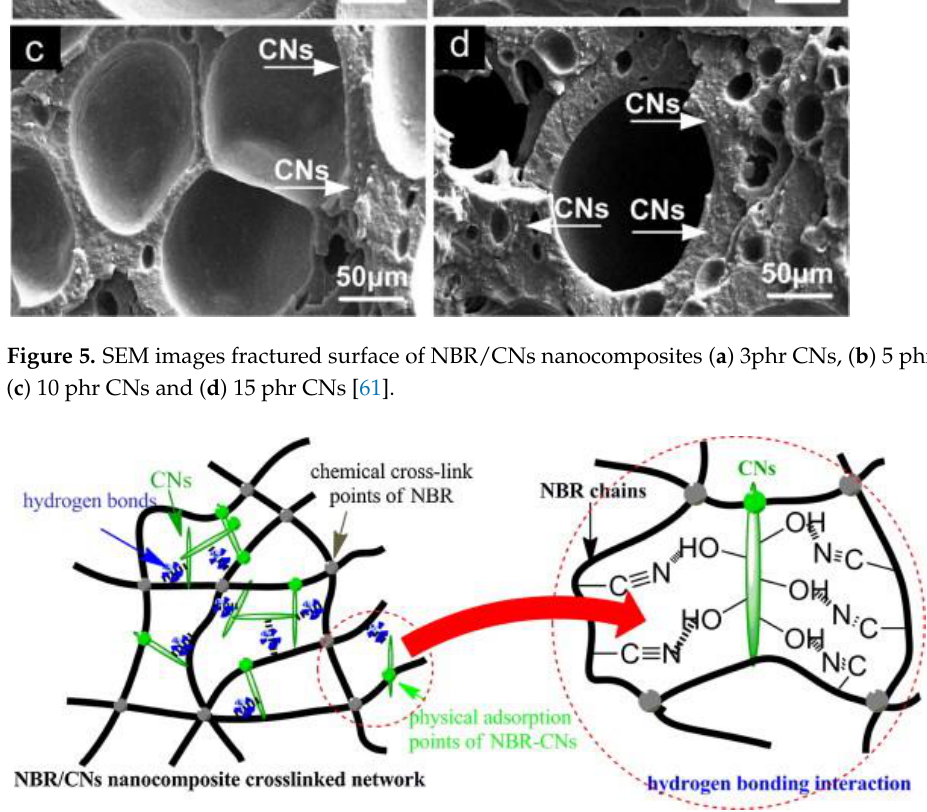
Figure 6. Possible scheme of crosslink network between NBR and CNs [61].